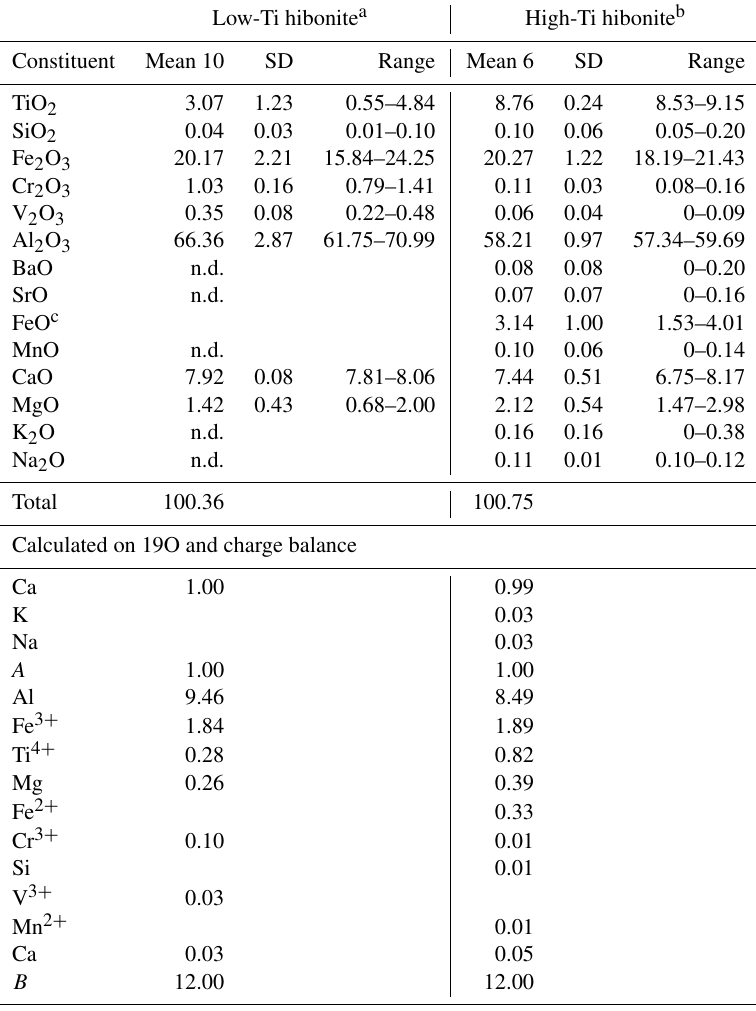
Low-Ti hibonite a